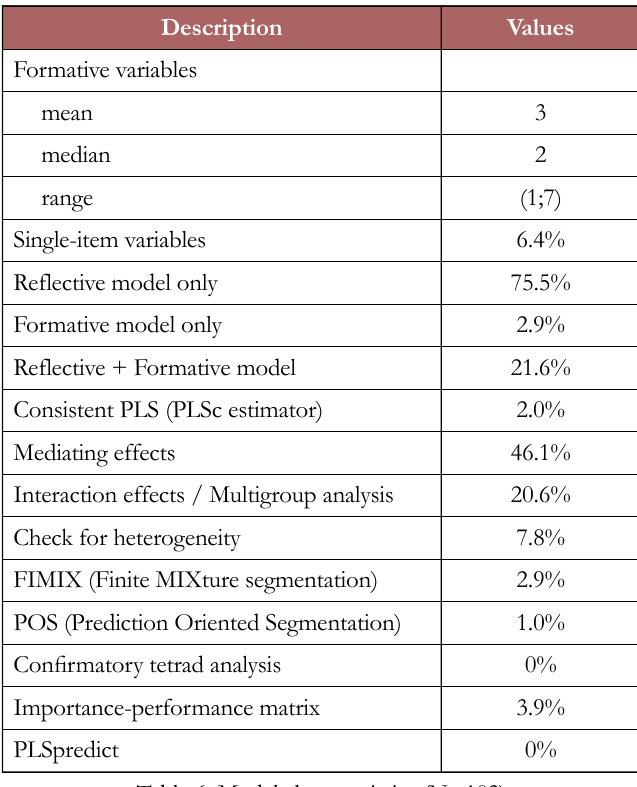
Table 6. Model characteristics (N=102)